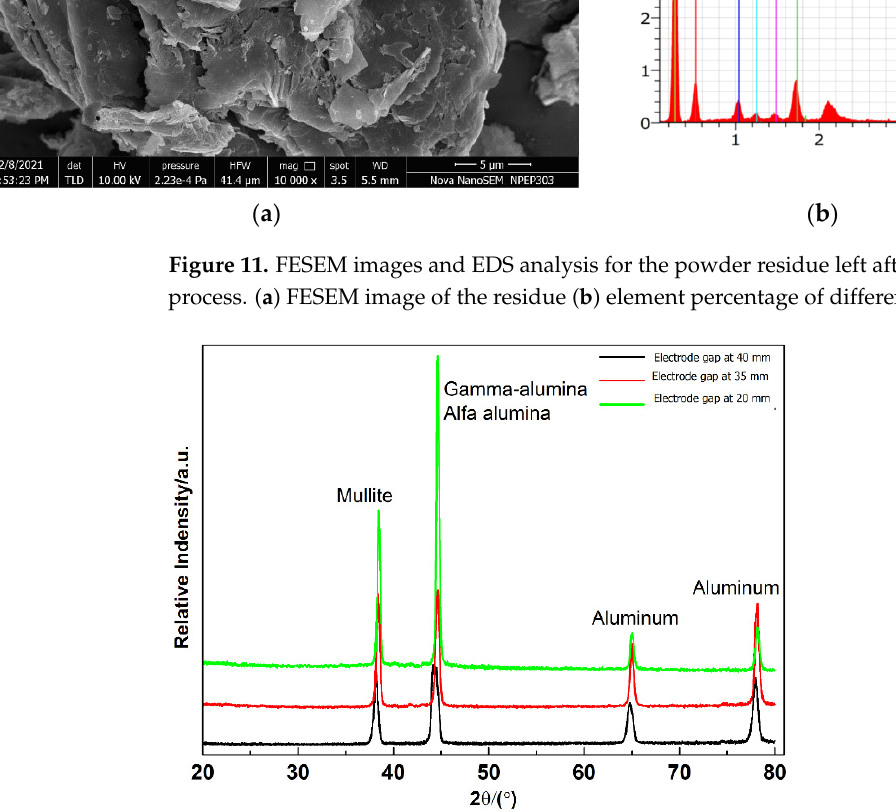
Figure 13. Elemental distribution SEM image for powder residue after experimentation. ( a ) Ele- ment distribution of Al,C,O , ( b ) Distribution of C ( c ) Distribution of Al , ( d ) Distribution of O , ( e ) Overall elemental distributions.